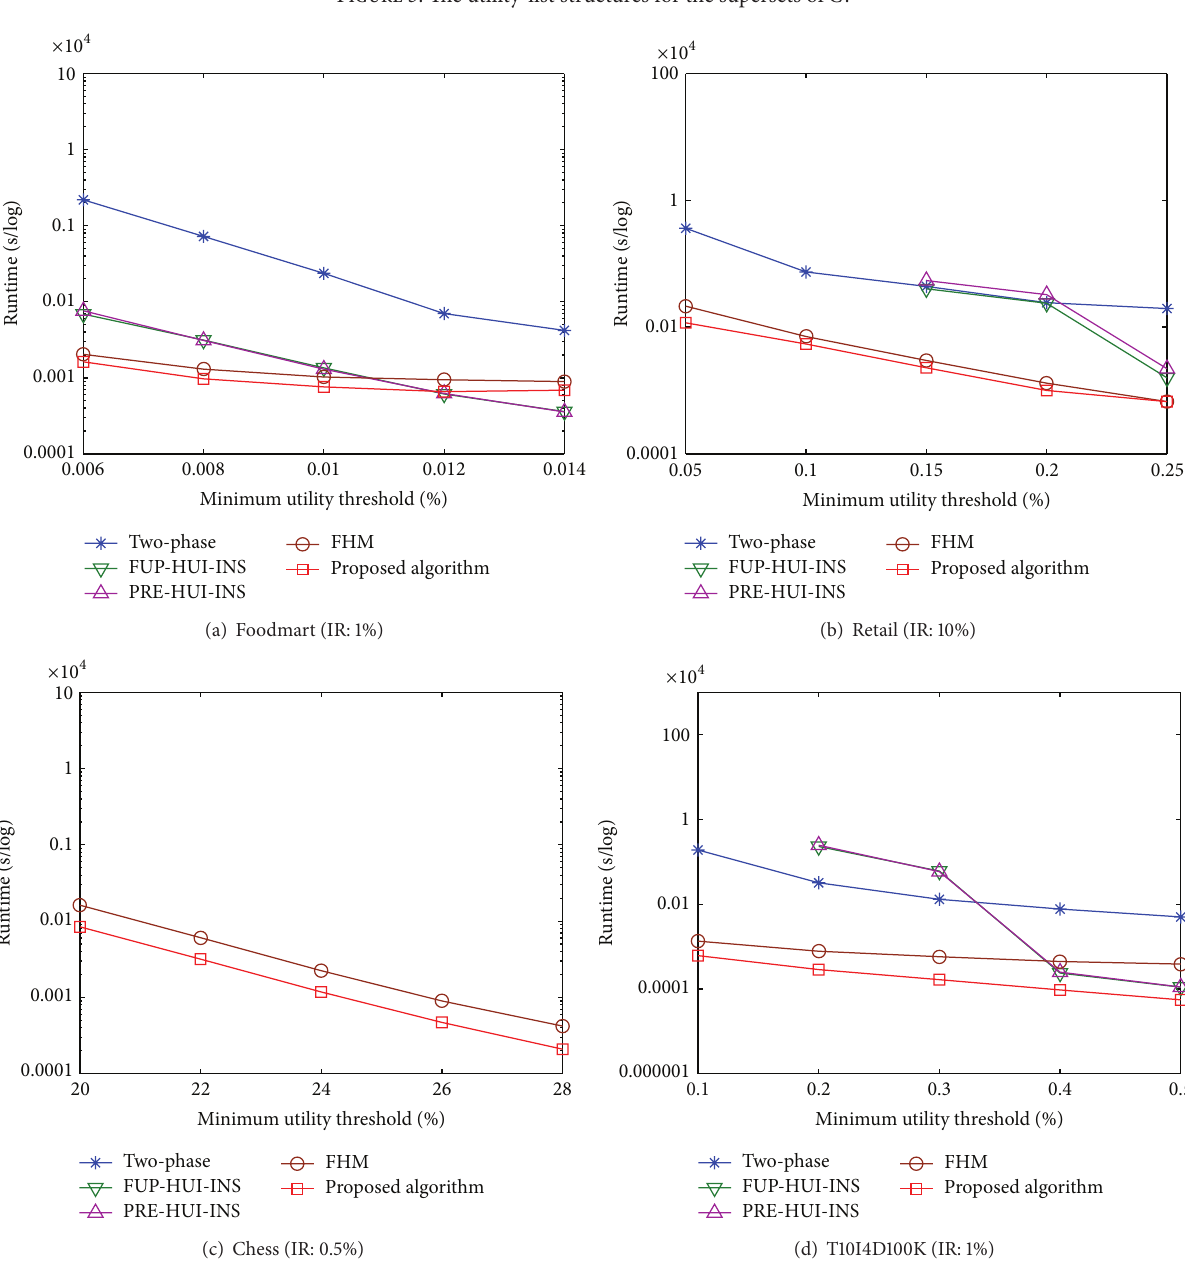
Figure 5: The utility-list structures for the supersets of 𝐶 .